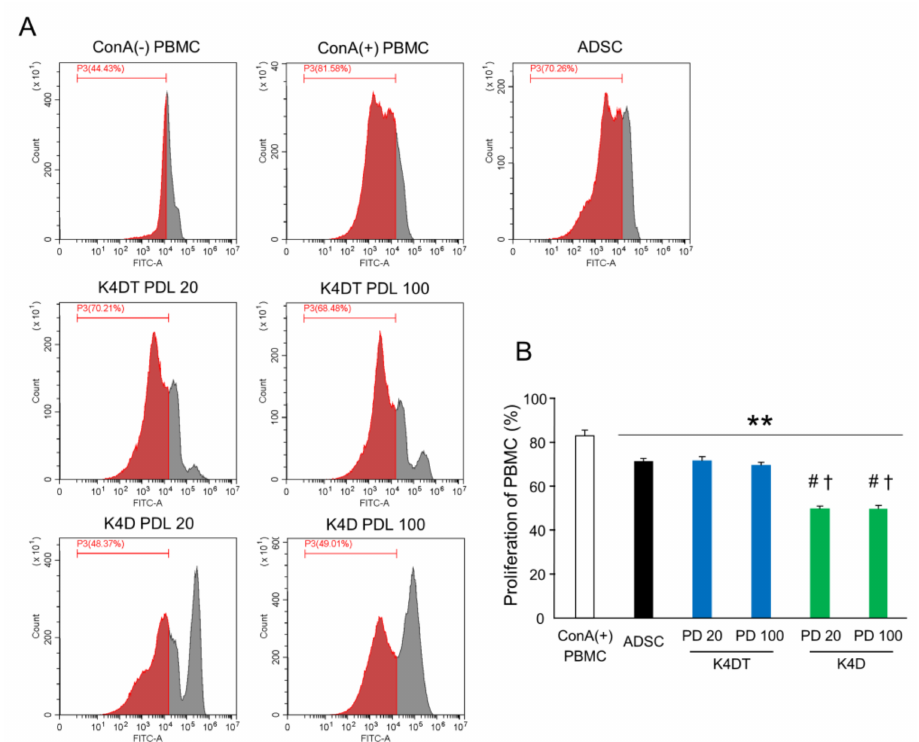
Figure 10. Proliferative ability of PBMCs cocultured with ADSC-K4DT and ADSC-K4D cells. ( A ) PBMCs were stained with carboxyfluorescein succinimidyl ester (CFSE) and cultured for 72 h with primary ADSCs, ADSC-K4DT, or ADSC-K4D cells. The PBMC proliferation was quantified as the percentage of CFSE low cells. ( B ) Comparison of proliferative PBMCs stimulated with ConA when cocultured with ADSC-K4DT and ADSC-K4D cells. The inhibitive effect on the PBMCs cocultured with primary ADSCs, and ADSC-K4DT and ADSC-K4D cells was significantly enhanced compared to only stimulation with ConA. The inhibitive effect on the PBMCs was not different between PDL 20 and PDL 100 of the ADSC-K4DT and ADSC-K4D cells, respectively. Data are expressed as the mean ± standard deviation; n = 6; ** p < 0.01 vs. ConA (+) PBMCs, # p < 0.05 vs. ADSCs, † p < 0.05 vs. ADSC-K4DT